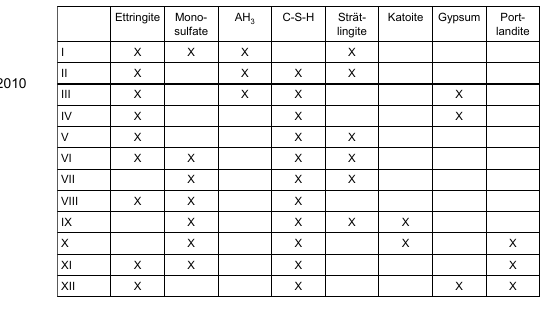
Figure 3. Stable hydrate assemblages in the system C 4 A 3 S